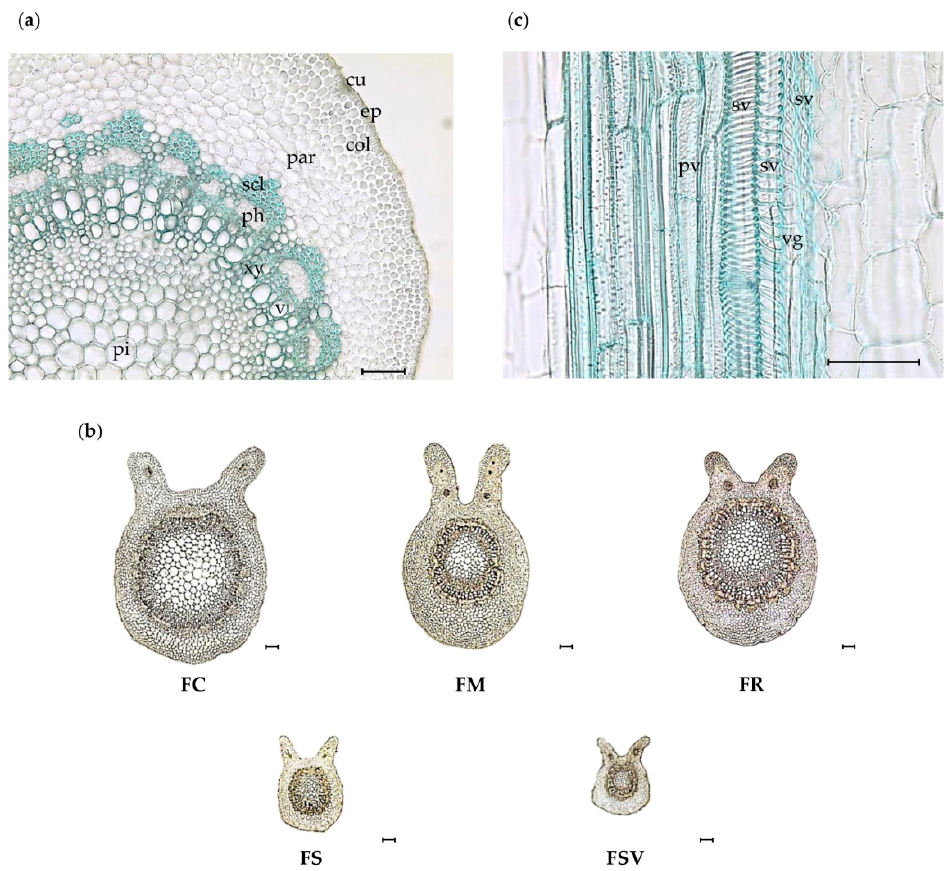
Figure 2. Photomicroscopic data of the petiole from five Fraxinus plants: ( a ) anatomical elements of petiole in transverse section ( × 200); ( b ) transverse section of the petiole of leaves from five Fraxinus plants (× 40); ( c ) different vessels of petiole in vertical section (× 400). Black bars mean 100 μ m; col , collenchyma cell; cu , cuticle; ep , epidermis; par , parenchyma cell; ph , phloem; pt , pith; pv , pitted vessel; s , starch grain; scl , sclerenchyma cell; sv , spiral vessel; vg , annular vessel; FC, Fraxinus chiisanensis ; FM, F. mandshurica ; FR, F. rhynchophylla ; FS, F. sieboldiana ; FSV, F. sieboldiana var. angustata . Table 2. Anatomical characteristics of the petiole of Fraxinus plants.